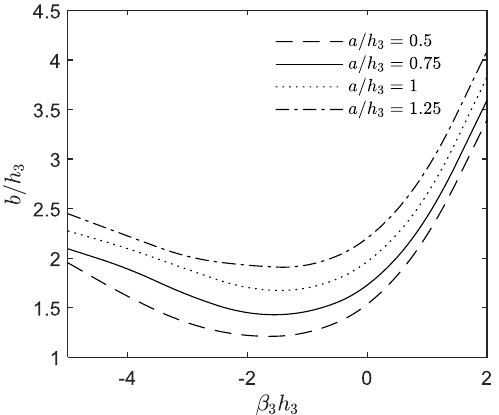
Figure 4. The effects of inhomogeneity parameter β 3 h 3 on the non–dimensionalized receding contact half–length ( µ 03 = µ 1 , h 2 = h 3 , β 2 h 2 = 0.001 ) .